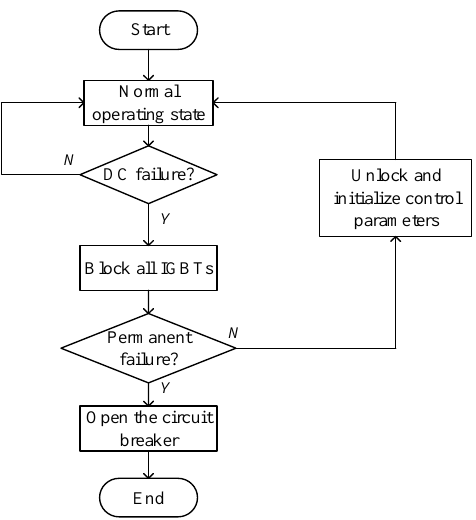
Figure 5. Flow chart of DC side fault ride through protection strategy.